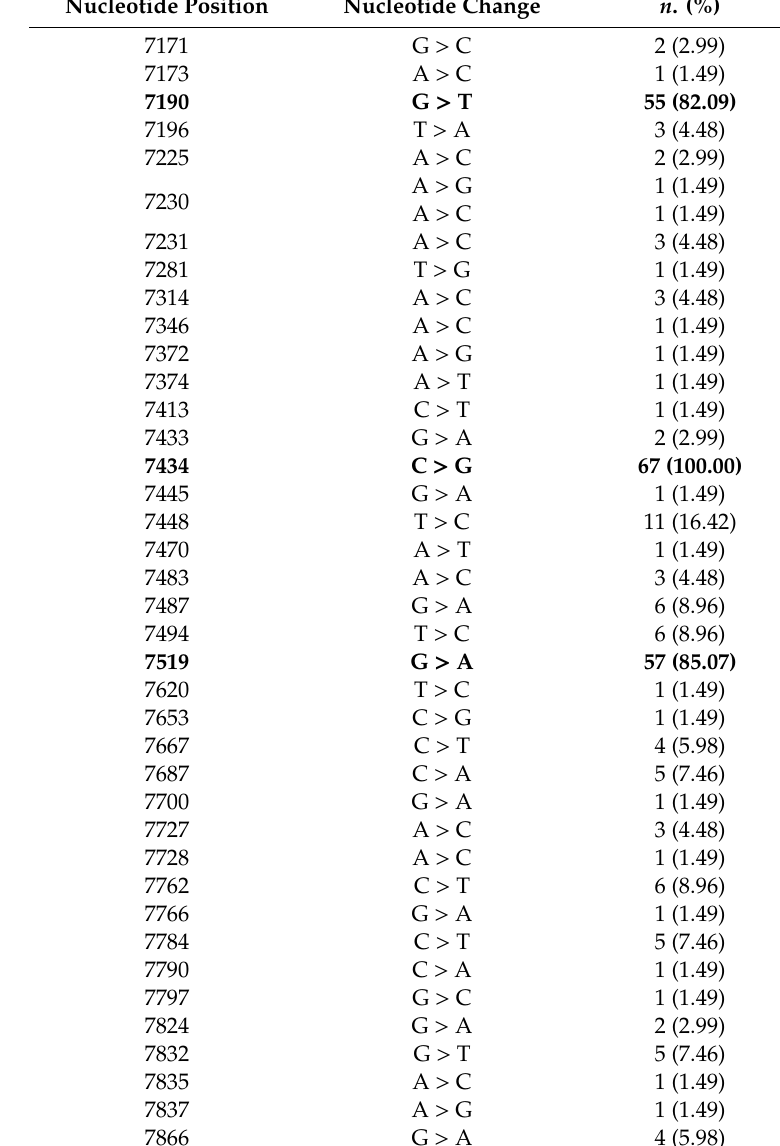
Table 3. Nucleotide sequence variations in the LCR of HPV 16 ( n = 67). Nucleotide